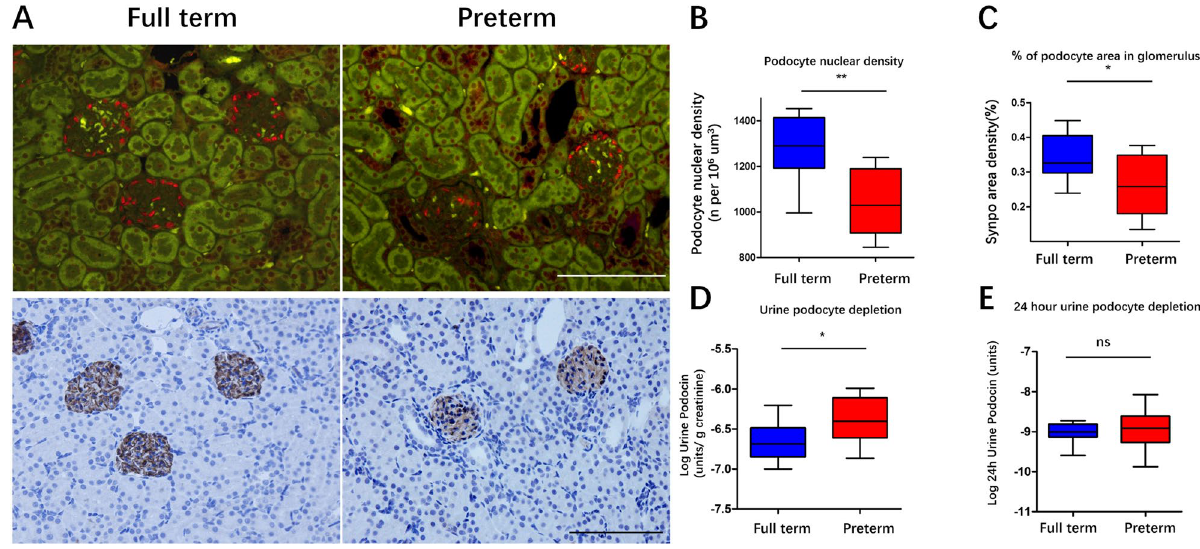
Figure 2. Effect of preterm birth on podocytes at postnatal week 3 in a rat model. ( A ) Podocyte density estimation by two independent methods. The upper panels show WT1-stained podocyte nuclei (red). The lower panels show SYNPO peroxidase-stained podocyte cell bodies in the same sections. Left panels illustrate full- term rat glomeruli. Right panels shown preterm rat glomeruli. Note that both podocyte nuclei and the podocyte area were decreased in preterm rats. Bar = 100 µm. ( B , C ) Biopsy podometric parameters of podocyte nuclear density and percent of podocyte aera in glomerulus showed that compared with the full-term rats (n = 9), the preterm rats (n = 8) have decreased podocyte numbers ( P < 0.01) and podocyte area ( P < 0.05). ( D , E ) Urine podometric parameters of the urine podocin mRNA-to-creatinine ratio (UpodCR) and the 24-h excretion of podocin mRNA (24 h Upod) are shown. The rate of podocyte mRNAs depletion in urine was increased in preterm rats compared to term rats when podocyte depletion was expressed as UpodCR ( P < 0.05), while there was no significant difference when podocyte depletion was expressed as 24 h Upod. (T-tests were used to compare parameters between preterm and full-term rats, *** P < 0.001; ** P < 0.01; * P < 0.05; ns: no statistically significant